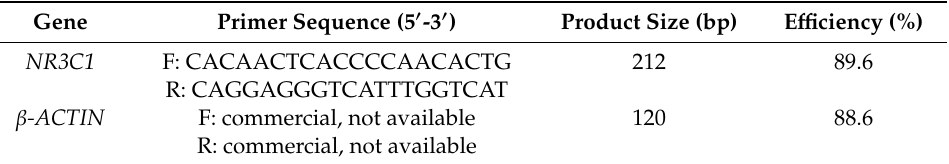
Table 1. Primers used for the quantitative PCR